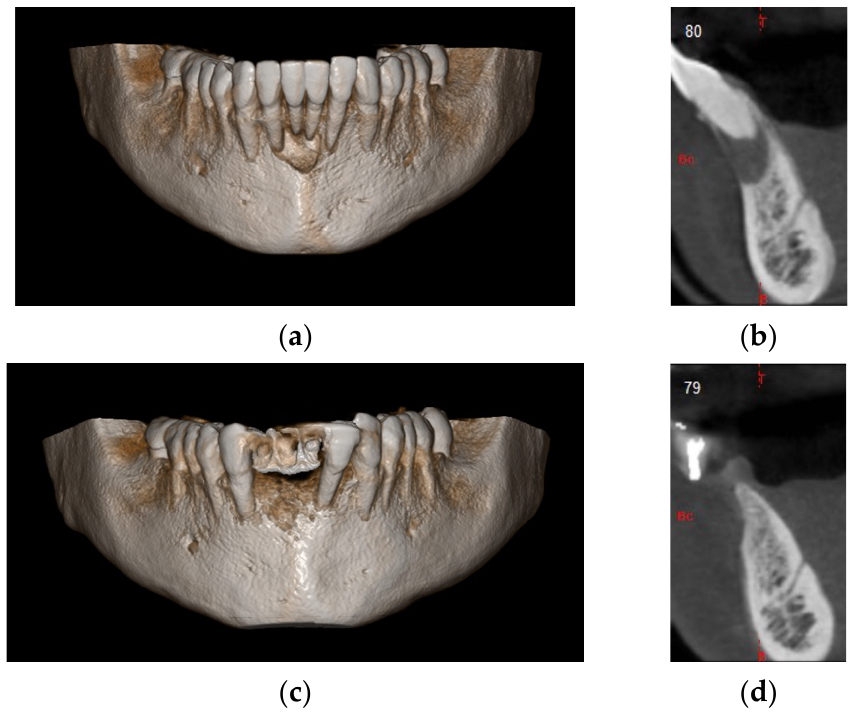
Figure 17. ( a ) Initial 3D situation; ( b ) CBCT of the initial situation; ( c ) Final CBCT post 3D regeneration after 4 months; ( d ) X-ray of the situation post regeneration after 4 months.